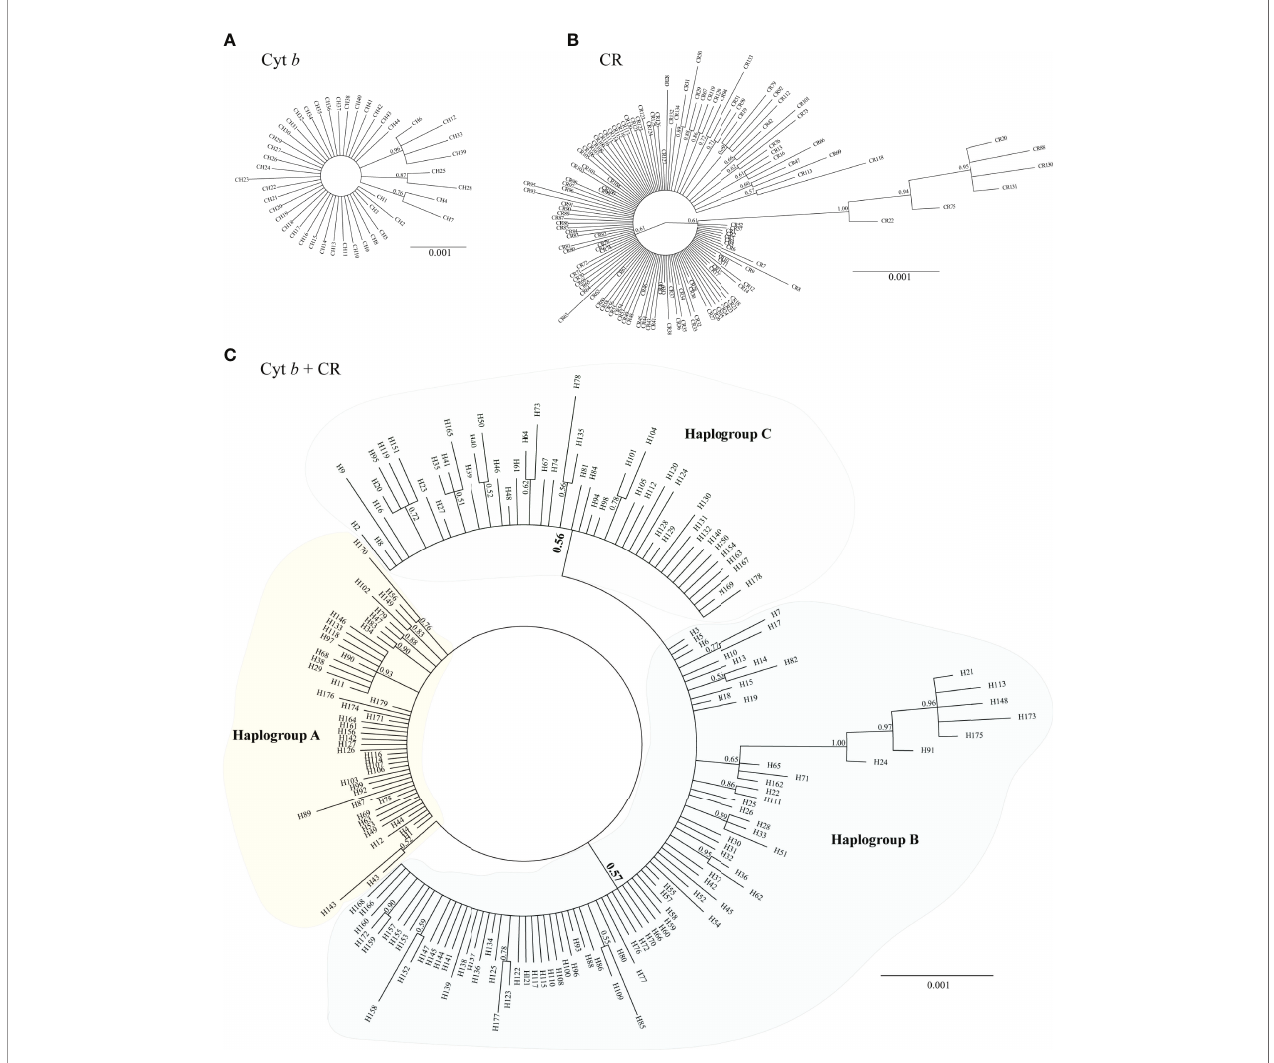
FIGURE 2 | Bayesian inference tree for (A) 44 Cyt b , (B) 134 CR, and (C) 179 Cyt b + CR haplotypes of D. maruadsi . Numbers close to branches indicate posterior probability values above